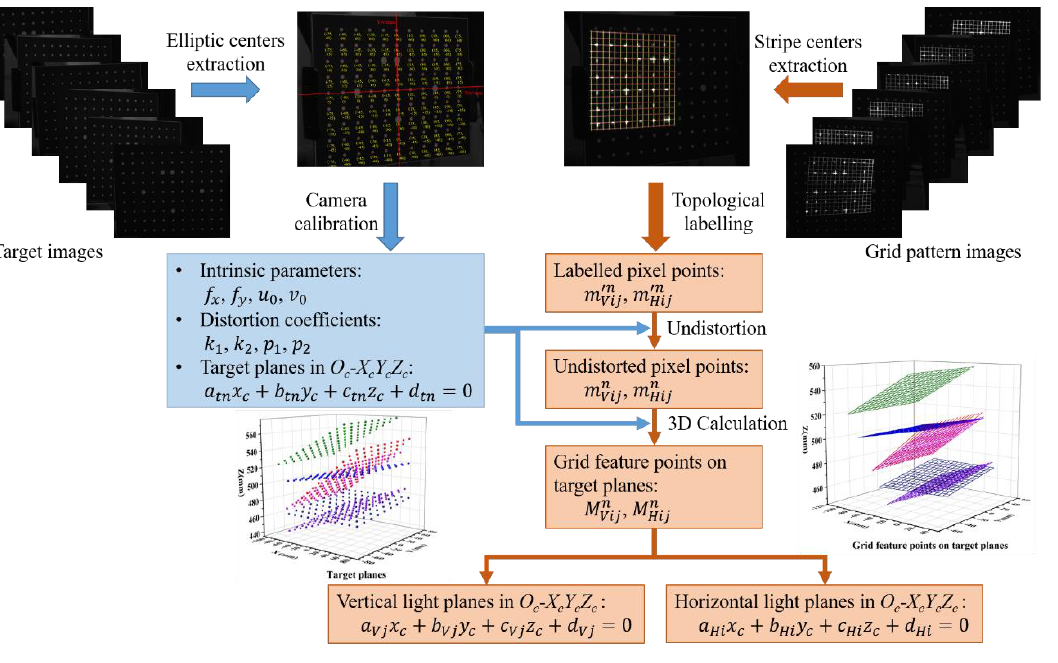
Figure 8. Calibration procedures.